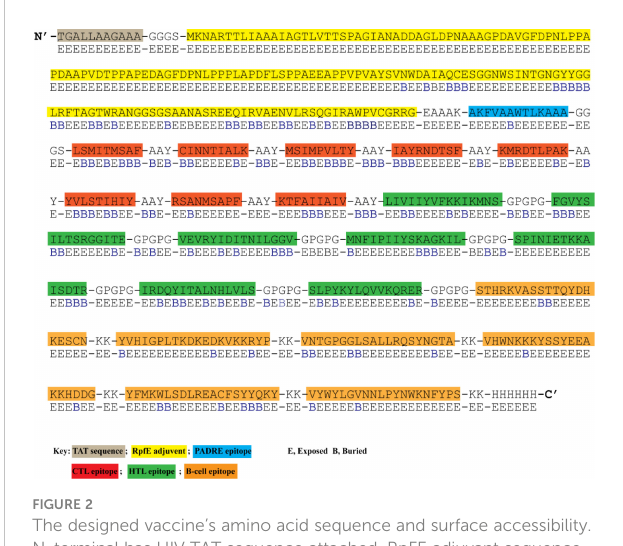
FIGURE 2 The designed vaccine ’ s amino acid sequence and surface accessibility. N-terminal has HIV TAT sequence attached. RpFE adjuvant sequence is highlighted in yellow color. PADRE epitope is shown in dark blue color. CTL, HTL, and B-cell epitopes are highlighted in red, green, and orange. Surface accessibility (NetSurfP - 3.0 sever) of each amino acid is shown as either exposed (E) or buried (B) residue.